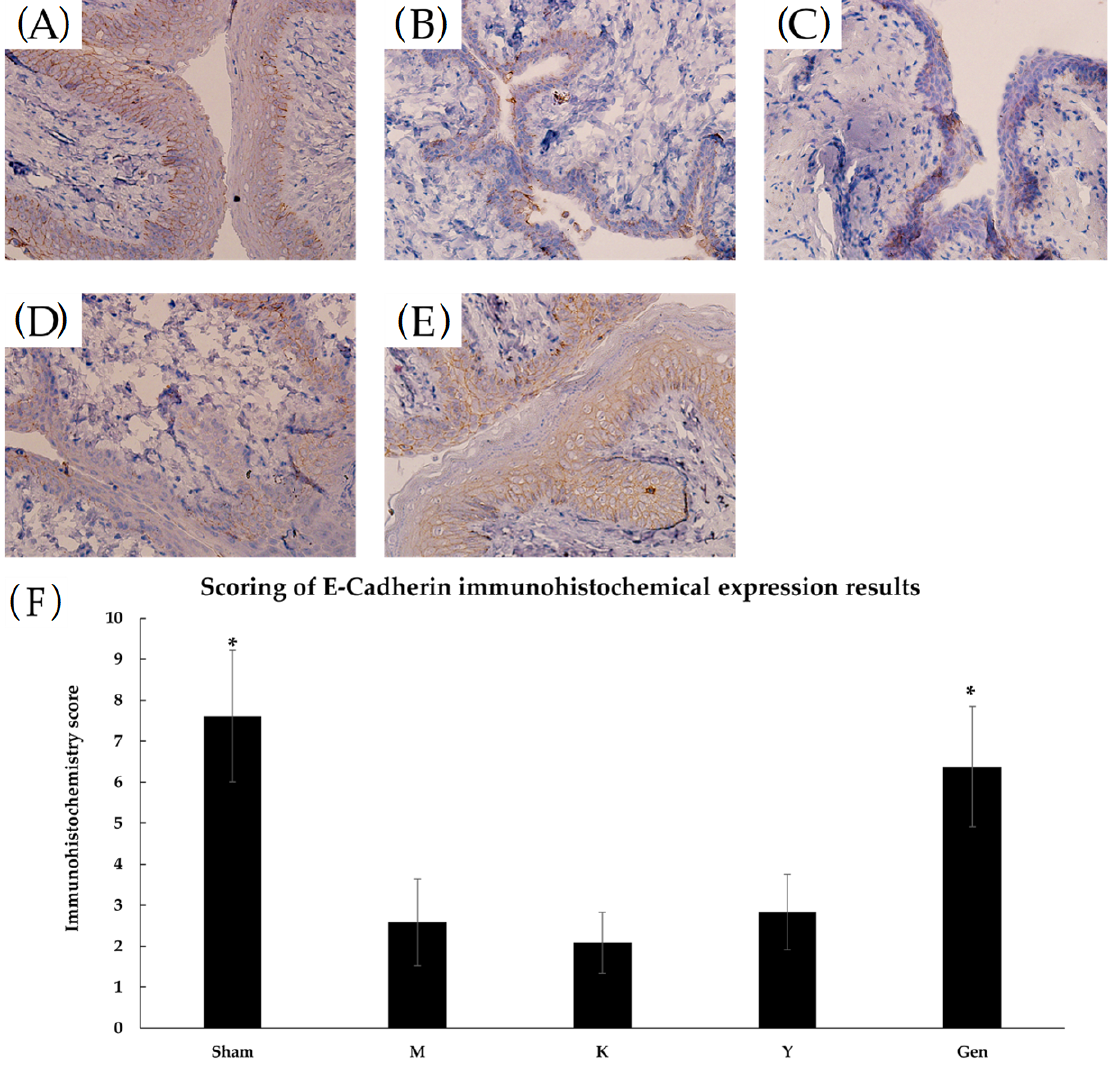
Figure 10. ( A ) High expression of E-cadherin protein in the vaginal tissues of Sham rats, (40X). ( B ) Low expression of E-cadherin protein in vaginal tissues of group M rats, (40X). ( C ) Low expression of E-cadherin protein in vaginal tissues of group K rats, (40X). ( D ) Immunohistochemical results of vaginal tissues of rats in group Y with low positive expression of E-cadherin protein, (40X). ( E ) Immunohistochemical results of vaginal tissues from the Gen group of rats were strongly positive for E-cadherin protein with high expression, (40X). ( F ) E-cadherin immunohistochemistry score results for each group. * p < 0.01 compared to the model